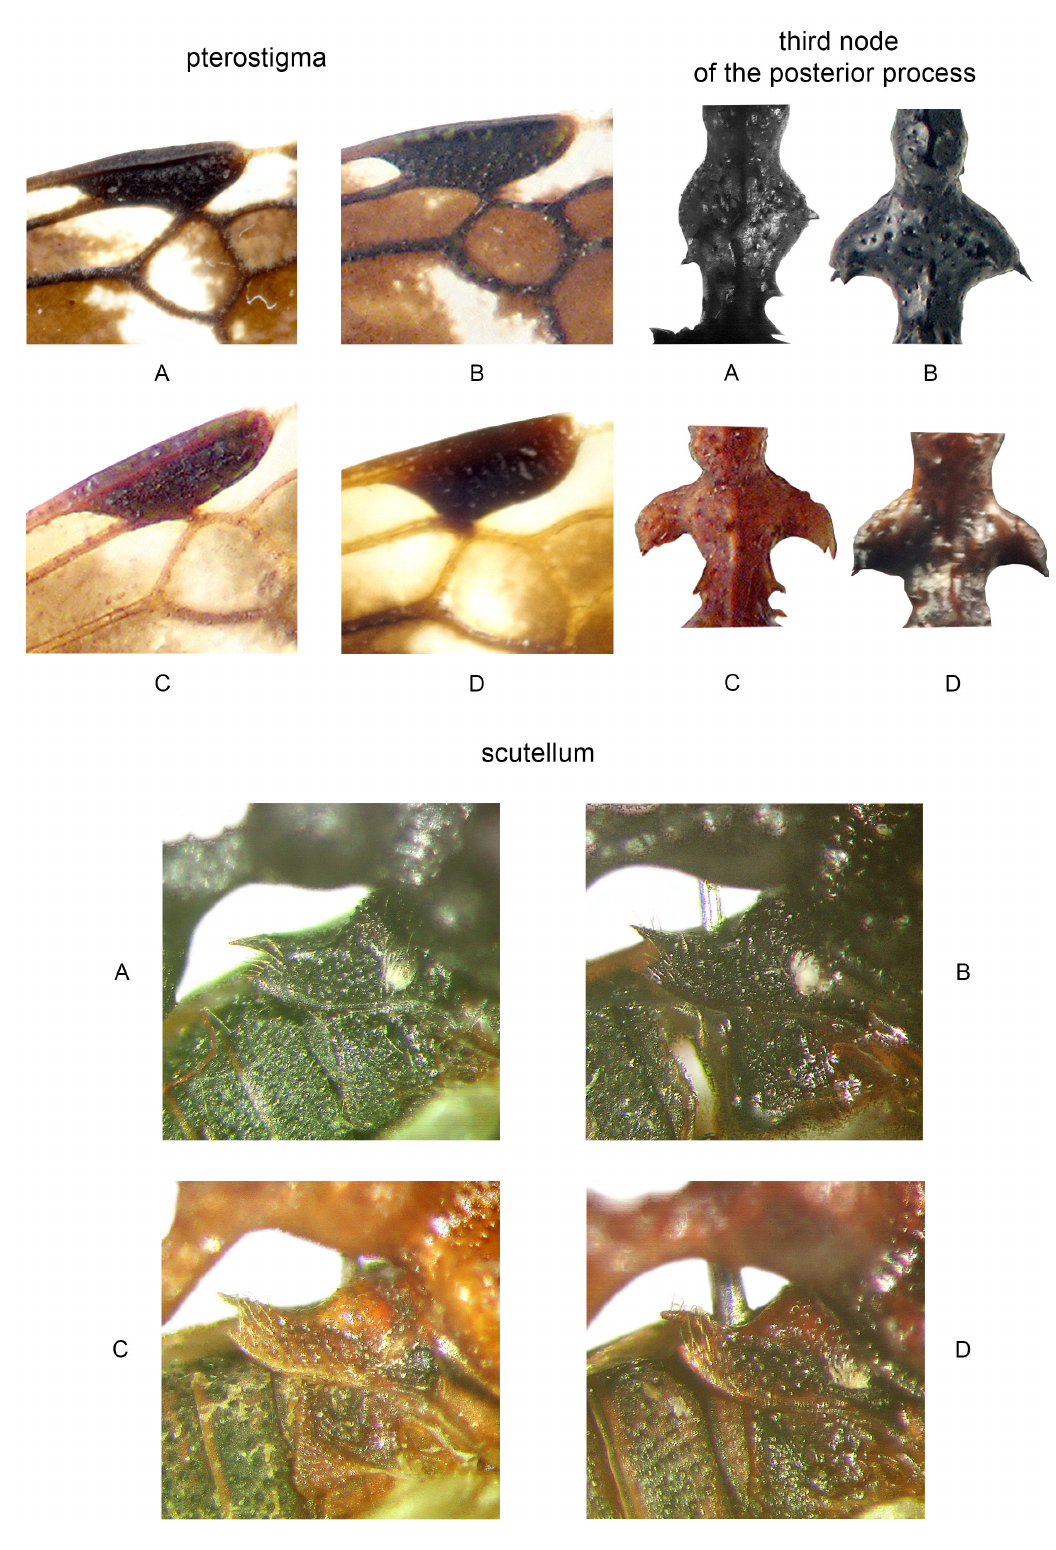
Fig. 5. Morphology. Pterostigma of right wing in dorsal view; third node of the posterior process in dorsal view; scutellum in lateral right view. A . Hamma heimi Boulard, 1968. B . Hamma nigrum sp. nov. C . Hamma spinellii sp. nov. D . Hamma caneparii sp. nov. Figures are not to